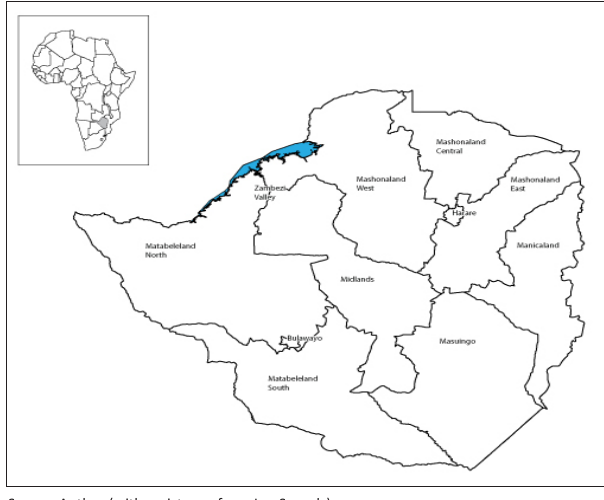
Source : Author (with assistance from Jon Swords) FIGURE 1: Relative regional location of Zimbabwe and its provinces. FIGURE 1: Relative regional location of Zimbabwe and its